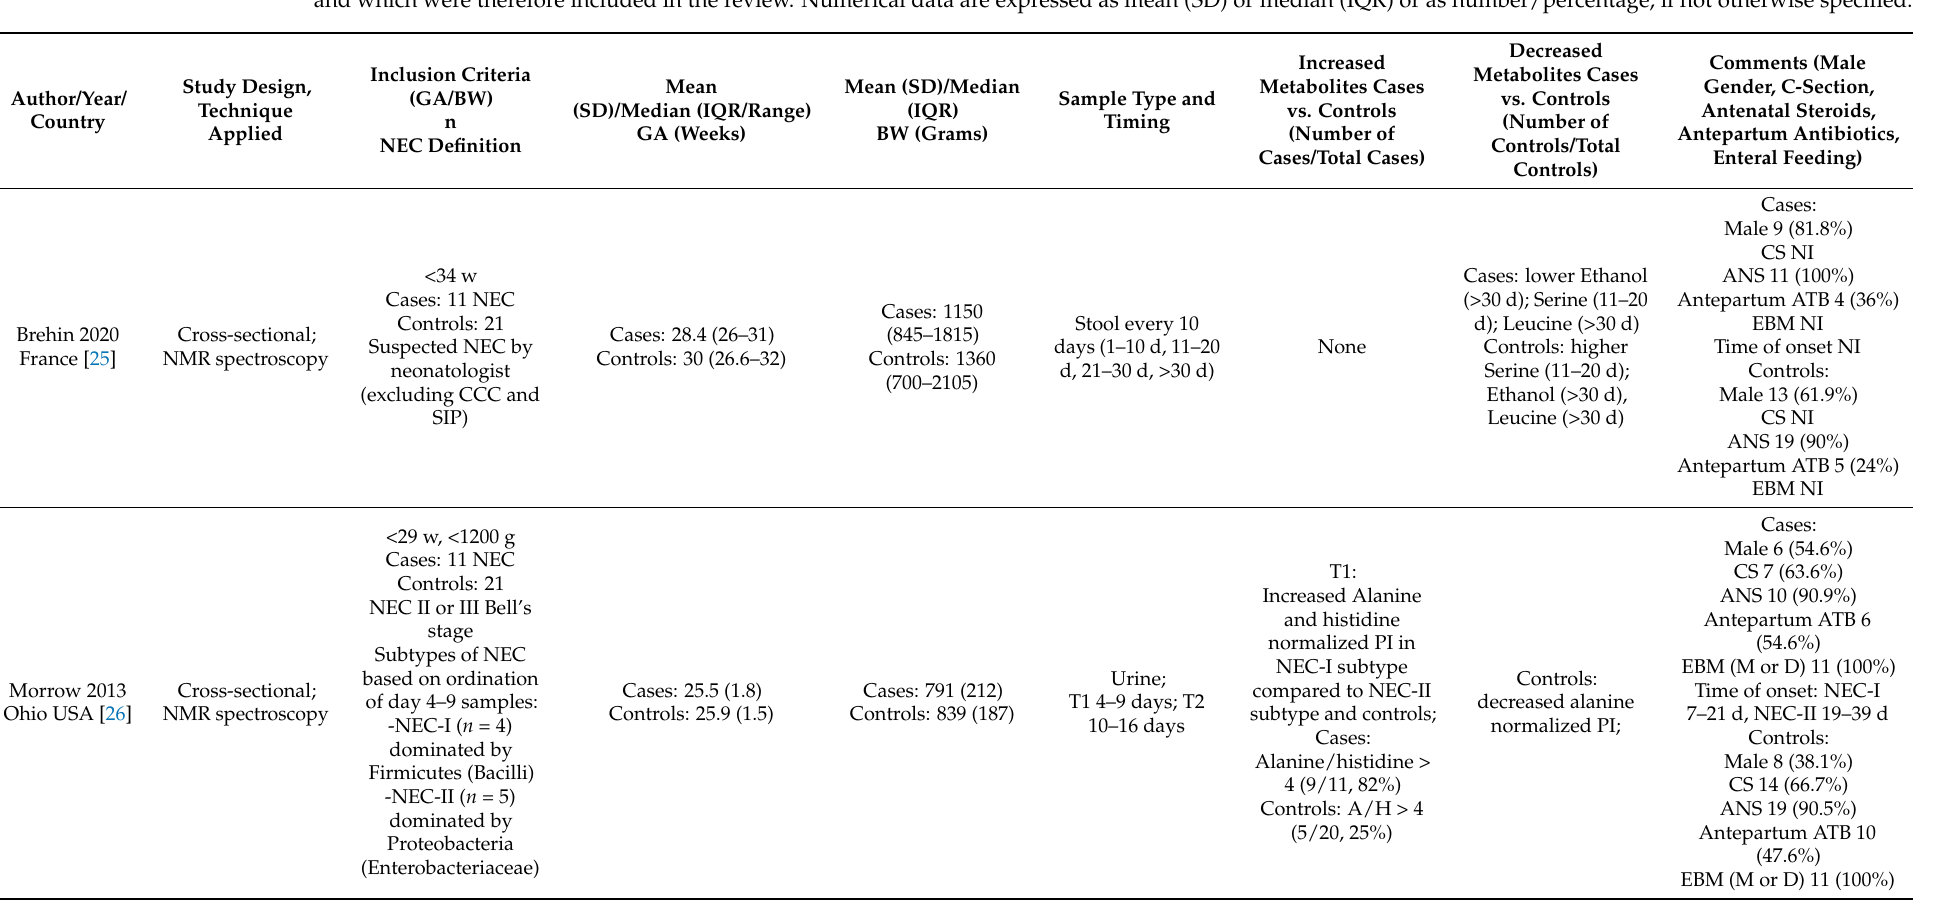
Table 1. Characteristics of studies applying untargeted metabolomic analysis for the predisposition/diagnosis of NEC/SIP (NEC/SIP prediction: early samples, first 14 days or >72 h from NEC onset; NEC diagnosis: late samples, <72 h from NEC onset). In grey shadow the studies which used NEC Bell’s stage II or III as definition and which were therefore included in the review. Numerical data are expressed as mean (SD) or median (IQR) or as number/percentage, if not otherwise